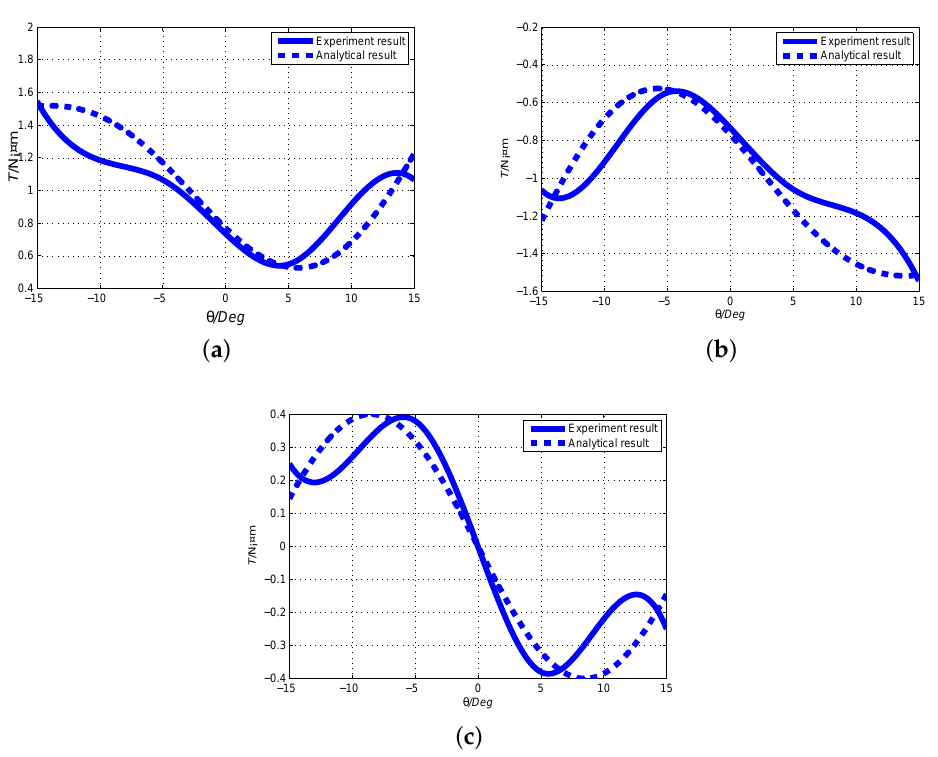
Figure 13. Comparison of output torque between experiment result and analytical result. ( a ) Output torque T o + when current direction is positive; ( b ) Output torque T o − when current direction is negative; ( c ) Output cogging torque T f